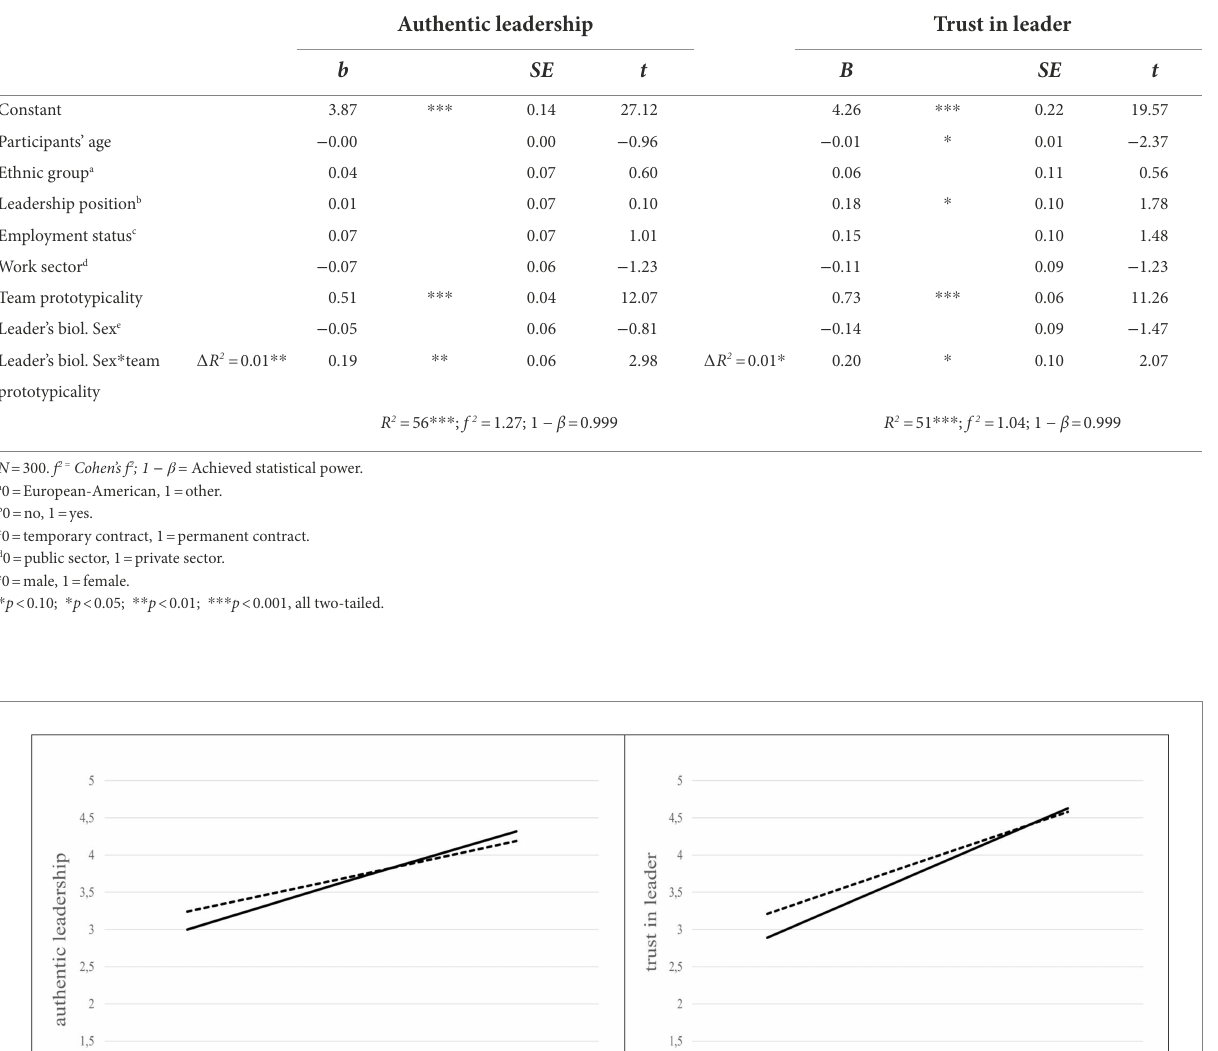
TABLE 5 Study 2: Results of hierarchical regression predicting authentic leadership and trust in leader (core model).